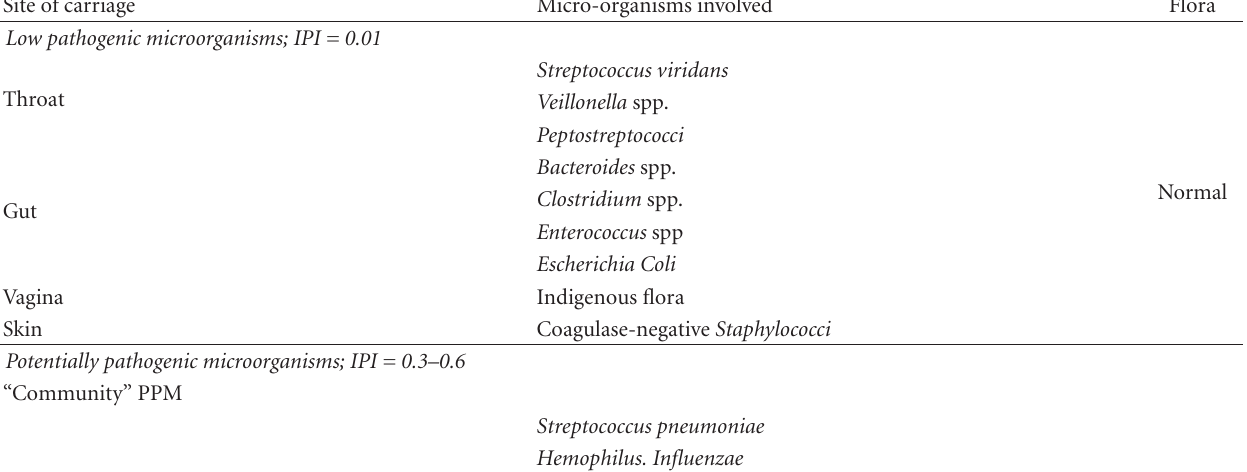
Table 1: Pathogenicity of